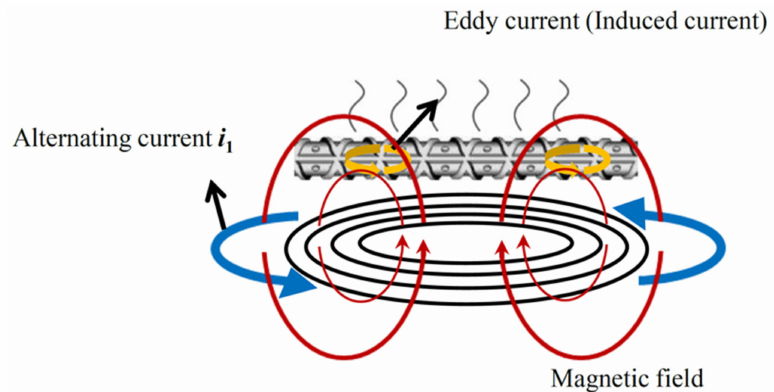
Figure 3. Heat generation model of reinforcing bars by induction heating